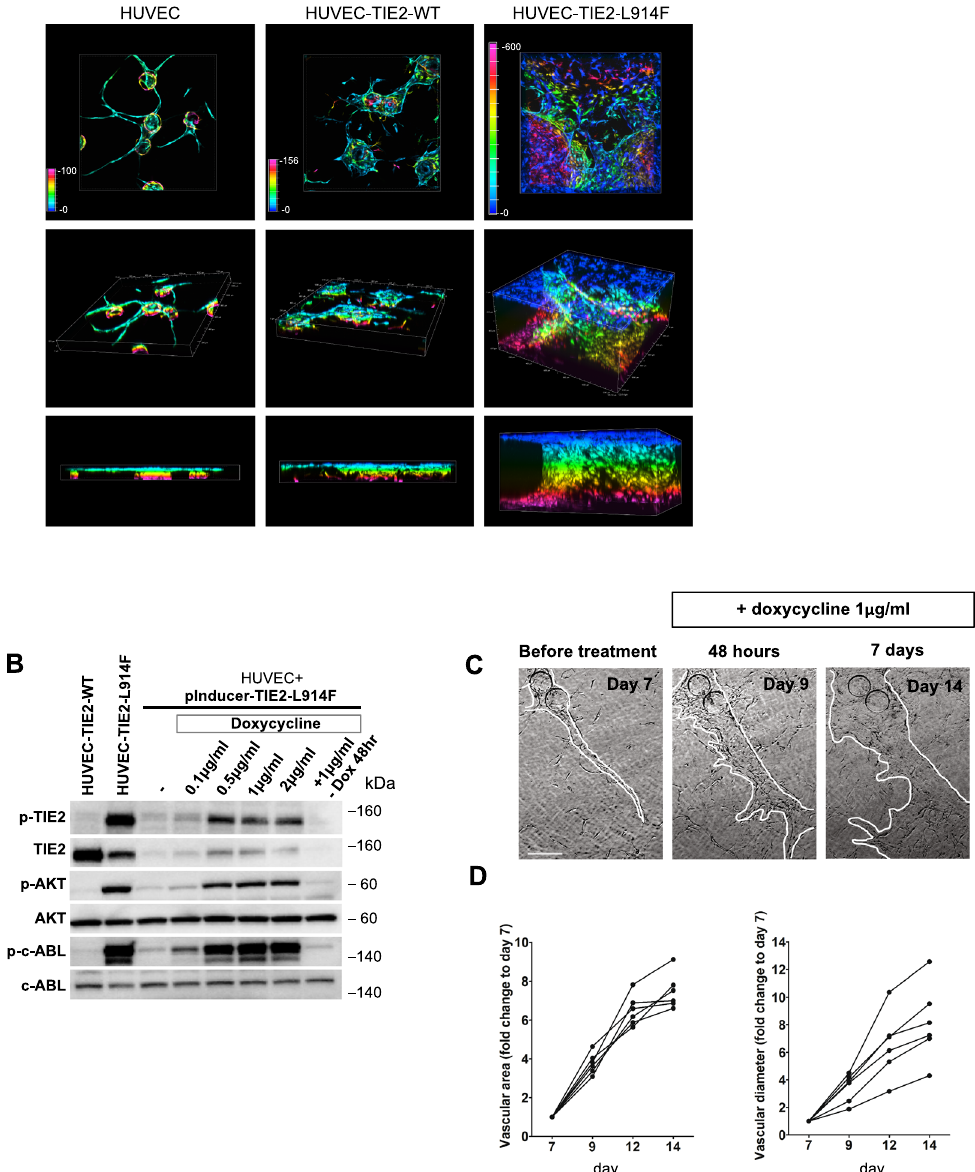
Figure 2. HUVEC expressing constitutive or inducible TIE2-L914F form massively enlarged vascular channels in a 3D fibrin gel. ( A) Depth color-coded z-stack images (max projection) at day 14 of HUVEC, HUVEC- TIE2-WT and HUVEC-TIE2-L914F in the fibrin gel (top panel), respective images of x-y-z axes (middle panel) and z-y axes (bottom panel). ( B) Western blot analysis of total cell lysates for the expression and activation levels of TIE2, AKT, c-ABL in HUVEC expressing a doxycycline-inducible form of TIE2-L914F (HUVEC- pInducer21-TIE2-L914F) treated with different concentrations of doxycycline for 48 hours, and control HUVEC-TIE2-WT and HUVEC-TIE2-L914F. ( C) Phase contrast images of HUVEC-pInducer21-TIE2-L914F 7 days after embedding into the fibrin gel subjected to doxycycline treatment 1 μ g/ml and analyzed after 2 (48 hours) and 7 days of continuous doxycycline administration. Scale bar: 100 μ m. ( D) Quantification of vascular area and lumen caliber at different time points after administration of doxycycline. (n = 6 independent vascular fields analyzed for each time